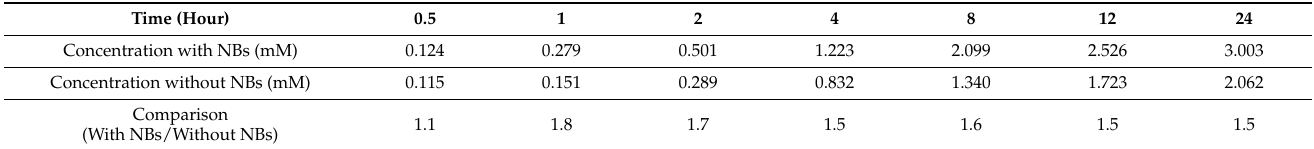
Table 1. Cumulative concentration of ingredients across the membrane over